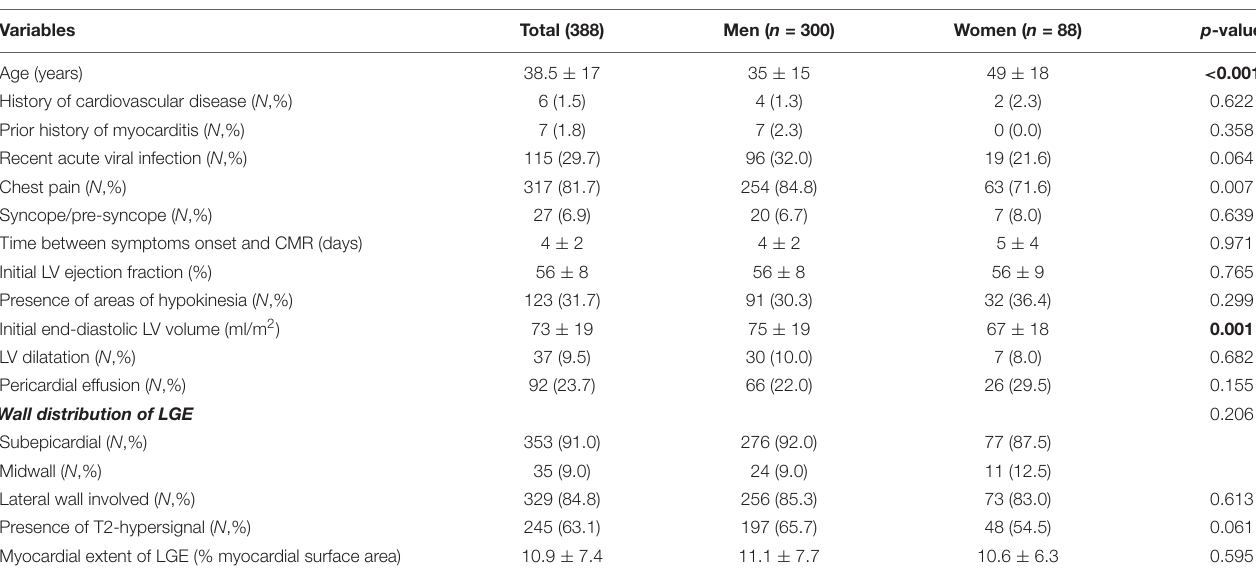
FIGURE 1 | Flow chart of the study. ∗ Other cardiac diseases were chemotherapy-induced cardiomyopathy, valve disease, arrhythmogenic right ventricular dysplasia, hypertrophic cardiomyopathy. ∗∗ Censored at the date of the last clinical contact. FU, follow-up. TABLE 1 | Baseline characteristics of study patients according to